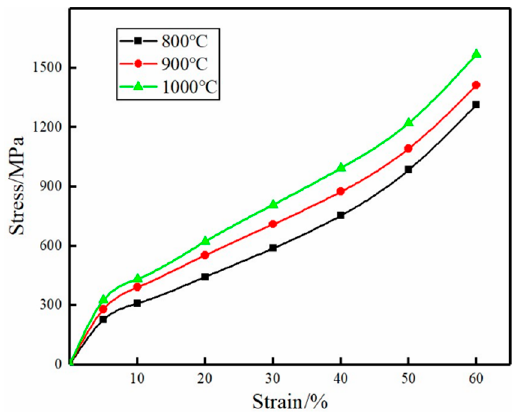
Figure 6. Stress–strain curves of the sample sintered at different sintering temperatures.